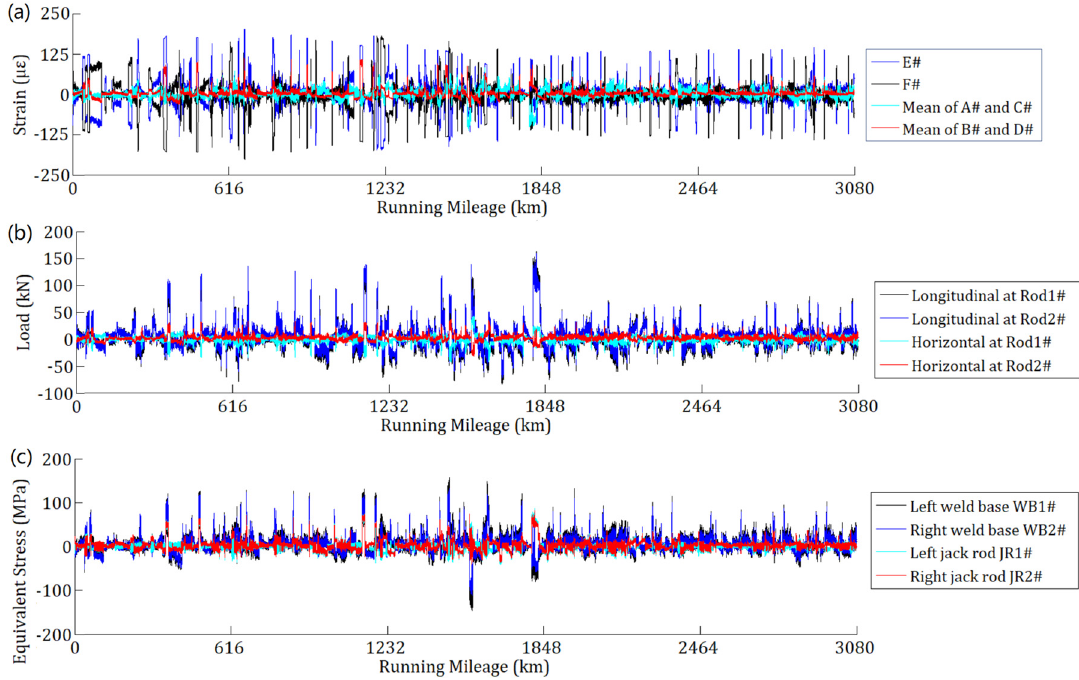
Figure 15: Mileage history of strain perception, identi fi ed load, and reconstructed stress: ( a ) surface strain; ( b ) identi fi ed load and ( c ) reconstructed